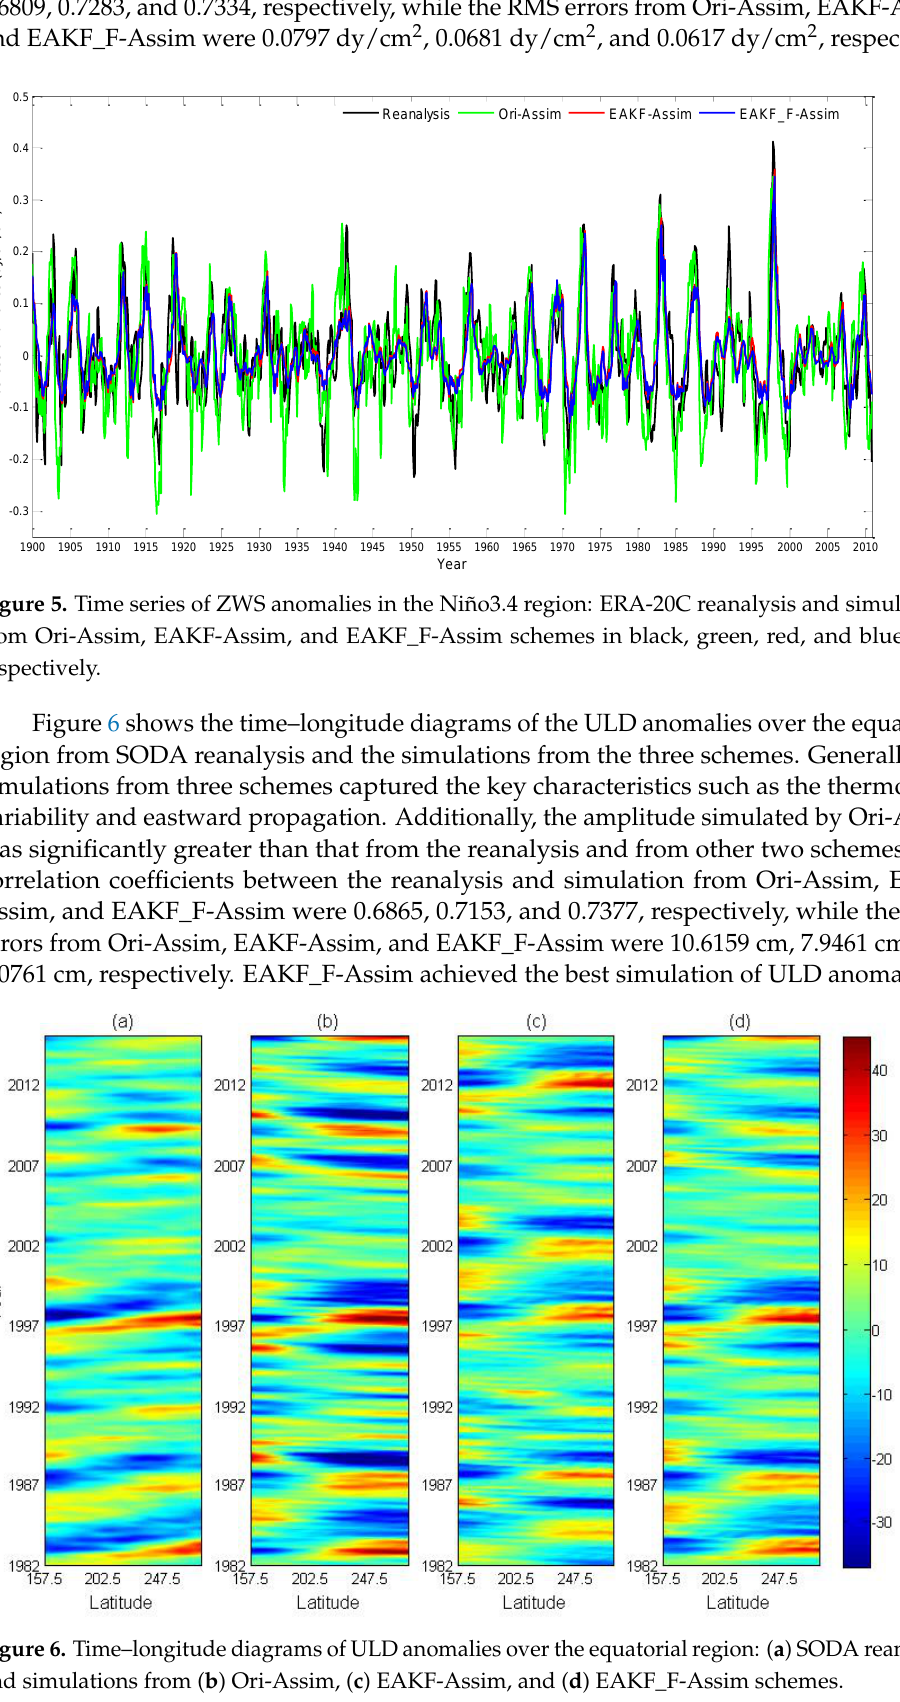
the reanalysis and simulation from Ori-Assim, EAKF-Assim, and EAKF_F-Assim was 0.6118, 0.7589, and 0.7631, respectively, while the RMS errors from Ori-Assim, EAKF-As- sim, and EAKF_F-Assim were 0.8581 °C, 0.8133 °C, and 0.7852 °C, respectively. Similar to the results of ZWS and ULD anomalies, EAKF_F-Assim got the best simulation of the subsurface thermal variability.